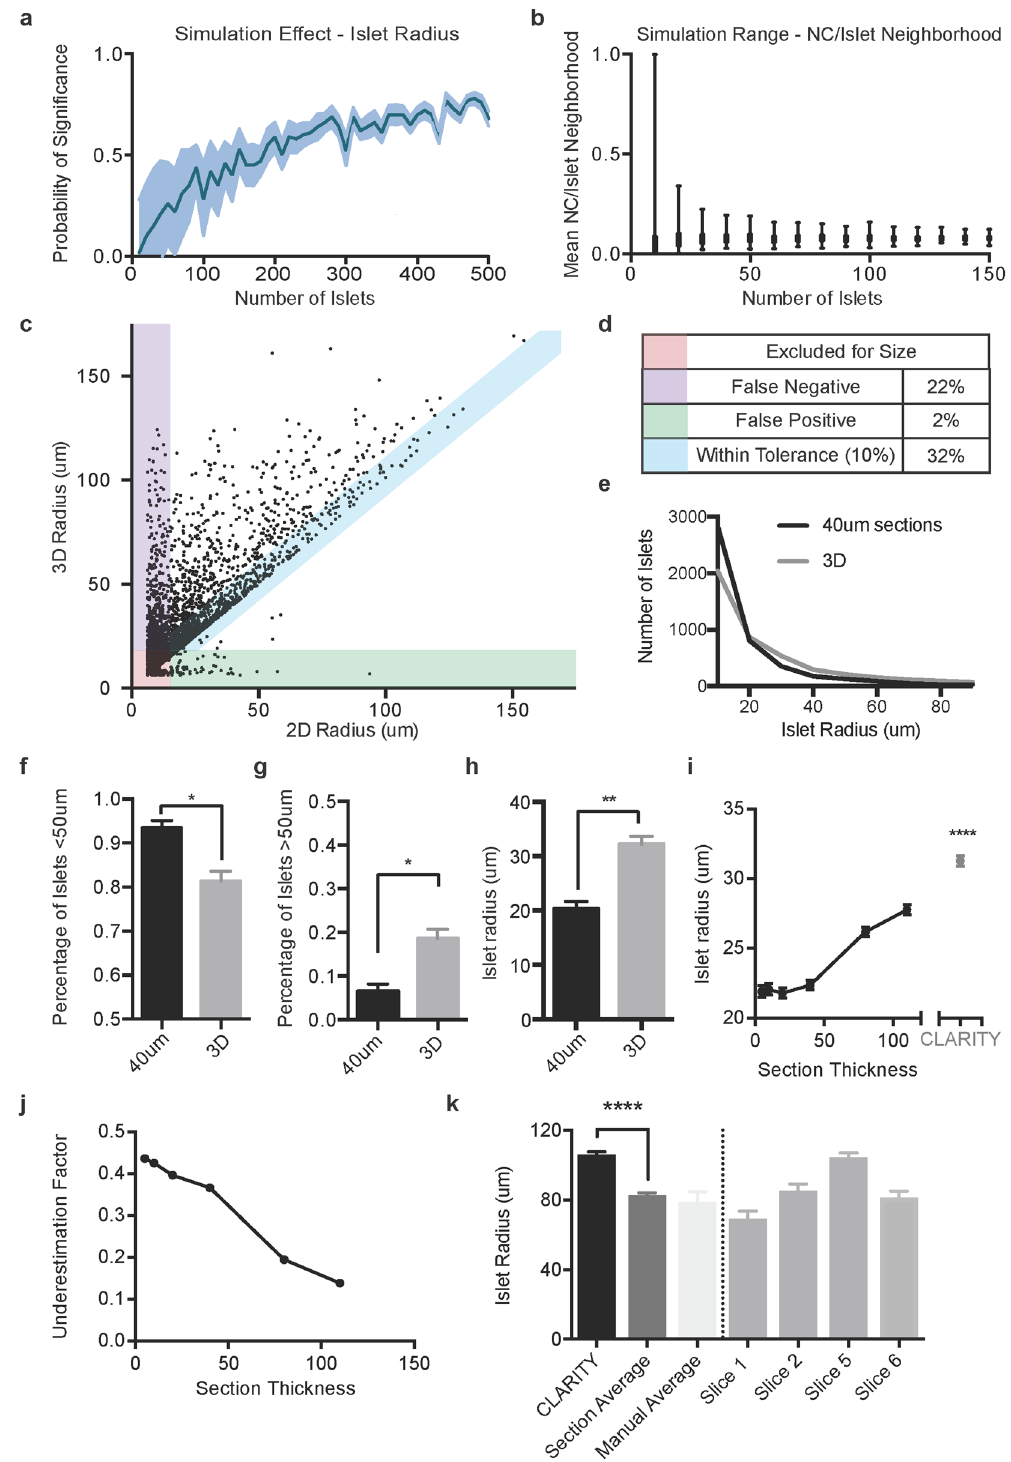
Figure 5. Computational demonstration of quantitative advantage of organ-wide 3D histology. ( a ) CLARITY enables automated analysis of large populations that provide greater statistical confidence. In a simulated experiment measuring islet radius, N islets were randomly selected, with replacement, from 3 P6 pancreata and 3 P15 pancreata CLARITY datasets, and islet radius means were compared. The proportion of experimental comparisons that reached statistical significance (p < 0.05, unpaired t-test) when the experiment was performed 100 times is plotted against the number of islets measured per experiment. When sampling the size of approximately 250 islets in each pancreas, there is only a 50% chance the data will be significant even though the true trend exists. ( b ) Large populations greatly reduce experiment-to-experiment variability. Bars show the range of the mean of N islets when a simulation measuring islet size and neural crest interaction was repeated 100 times. The width of the experimental ranges, and hence experiment-to-experiment variability,